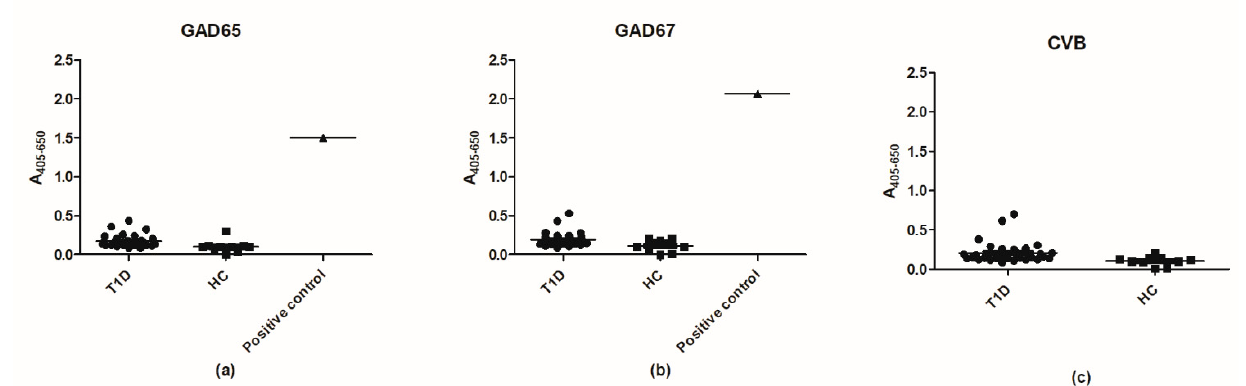
Figure 12. Reactivity of type 1 diabetes sera (T1D) ( n = 32) and healthy donor (HD) sera ( n = 10) to glutamic acid decarboxylase (GAD)65, GAD67, and coxsackievirus (CVB) peptides analyzed in enzyme-linked immunosorbent assay. ( a ) Reactivity of T1D and HC sera to the full-length GAD65 peptide. ( b ) Reactivity of T1D and HD sera to the full-length GAD67 peptide. ( c ) Reactivity of T1D sera and HD sera to the full-length CVB peptide.